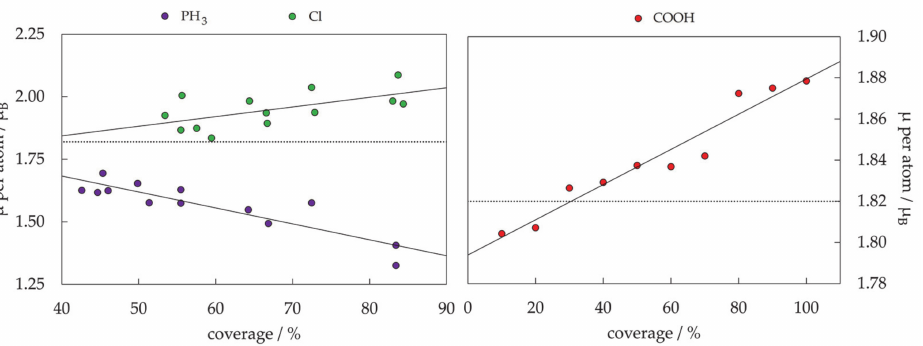
Figure 18. Average magnetic moment per Co atom, µ , as a function of ligand coverage for icosahedron Co mNPs passivated with Cl and PH 3 ( left ) and COOH ( right ). Average magnetic moment per Co atom for unpassivated 55-atom Co icosahedron is added as the dotted line. Data on the left are taken from Hartmann (2018) [396], and data on the right are taken from Farkaš (2021)